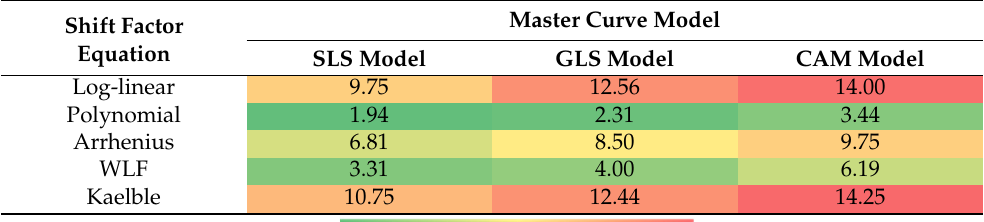
Table 5. Comparison of fits for three master curve models and five shift factor equations. Shift Factor Equation